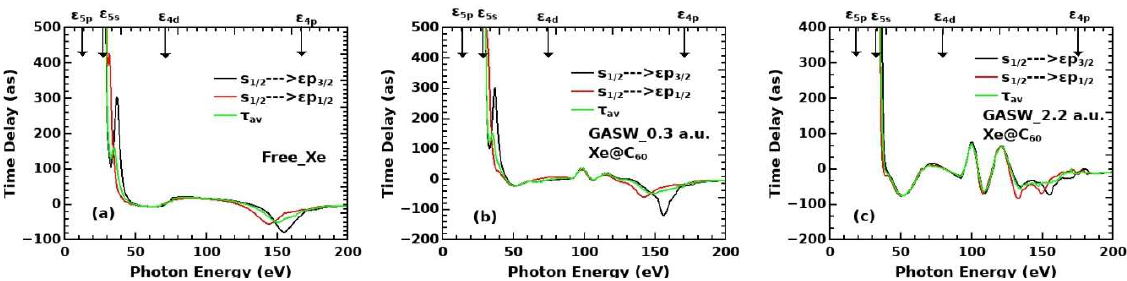
Figure 15. Time delay of photoionization from the 5s subshell of ( a ) free and confined Xe using the depths of ( b ) 0.3 a.u. ( middle panel ) and ( c ) 2.2 a.u. ( right panel ). Vertical arrows indicate the threshold values of the corresponding subshells used in the RRPA.